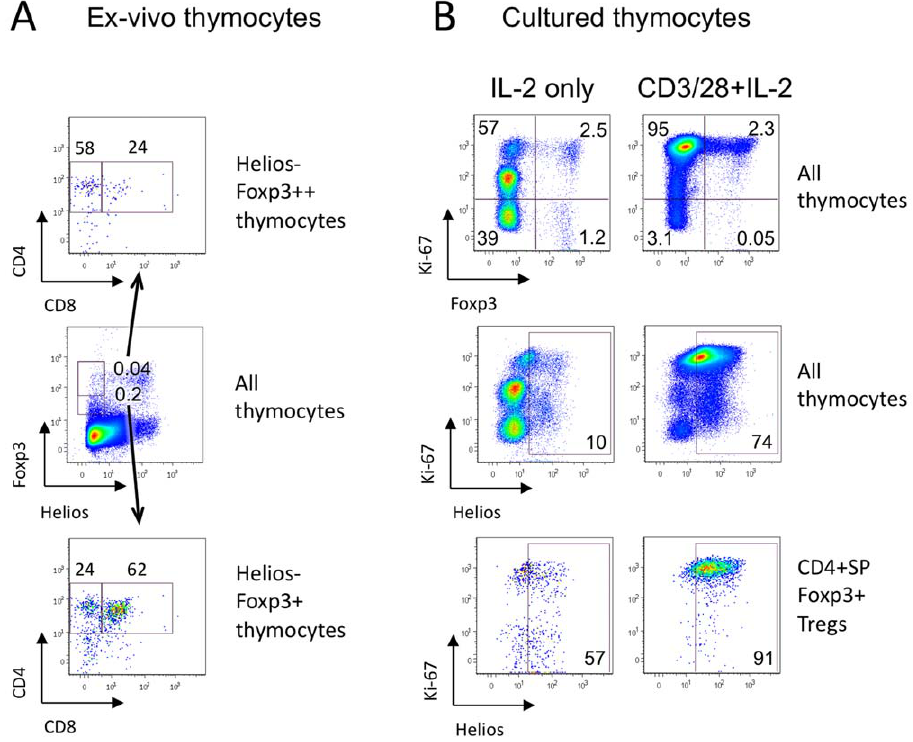
Figure 9. Helios expression in thymocytes depends on cell stimulation and not origin. (A) Helios- Foxp3 + subsets were gated within murine thymic cells, and CD4 and CD8 distribution was analyzed. More than half (bottom) of Foxp3 + Helios- cells and 24% (top) of Foxp3 hi Helios- cells in the thymus were immature CD4 + CD8 + DP thymocytes. (B) Murine thymic cells were incubated for 3 days with IL-2 only (non-stimulated, left column) or were stimulated with CD3/CD28 mAbs and IL-2 (stimulated, right column). Ki-67 expression (top) and Helios expression (middle) in non- stimulated cells decreased markedly; and Helios expression in thymic Tregs (CD4 + SP Foxp3 + cells) decreased from 91% to 57% (bottom).